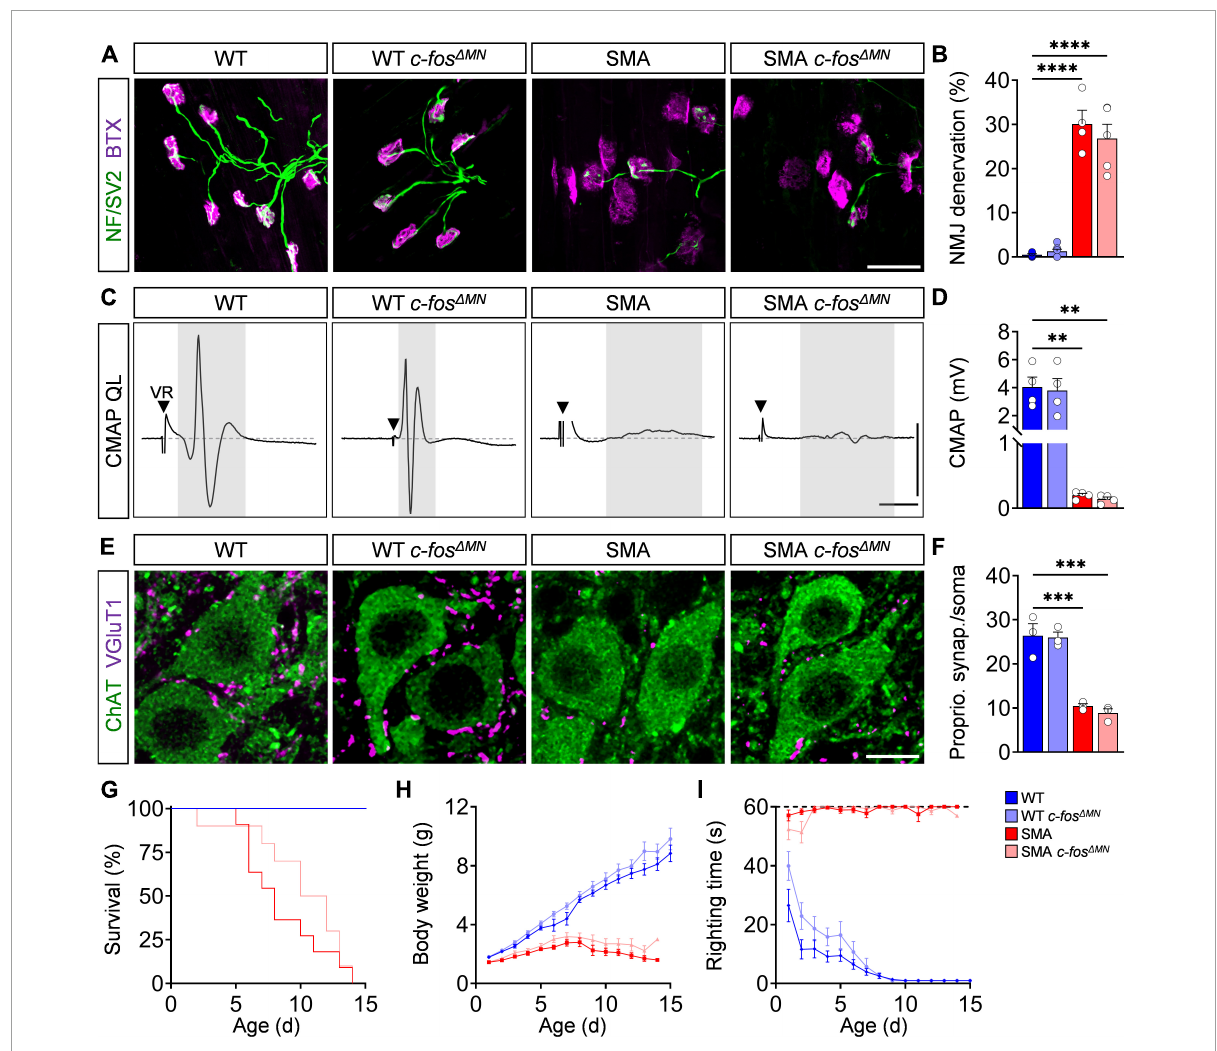
FIGURE4 c-Fos deletion in motor neurons has no impact on spinal muscular atrophy (SMA) spinal motor circuits and phenotype. (A) Neuromuscular junction (NMJ) staining with bungarotoxin (BTX, magenta), SV2 and neurofilament-M (both green) in the quadratus lumborum (QL) muscles P10 control wild-type (WT), SMN (cid:49) 7 mutant (SMA) and control (WT c-fos (cid:49) MN ) or SMN (cid:49) 7 mutant ( c-fos (cid:49) MN ) with MN-specific c-Fos knockout, respectively. Scale bar = 50 µ m. (B) Percentage of NMJ denervation of the QL muscle from the same groups as in panel (A) . n = 4–7 per genotype. (C) Compound muscle action potential (CMAP) recordings from the QL muscle following L1 ventral root (VR) stimulation from the same groups as in panel (A) at P10. Black triangles indicate stimulation artifact and gray box labels CMAP response. Scale bars = 1.5 mV, 3 ms. (D) Quantification of CMAP amplitude in mV recorded from the QL muscle in the same groups as in panel (A) at P10. n = 4 per genotype. (E) Immunostaining of VGluT1+ synapses (magenta) and ChAT + L1 motor neurons (green) from the same groups as in panel (A) . Scale bar = 10 µ m. (F) Number of VGluT1 + synapses on L1 motor neuron somata from the same groups as in panel (A) . n = 3 per genotype. (G–I) Survival, body weight and righting time for the same groups as in panel (A) . n = 9–12 per genotype. Statistics: one-way ANOVA with Tukey’s correction for panels (B,D,F) , Mantel–Cox test for survival (G) , multiple t -test with Holm–Sidak method for body weight (H) and righting time (I) . Each data point (n) represents one animal. Asterisks on top of bars without horizontal line indicate the significance compared to another group. ** p < 0.01; *** p < 0.001, **** p <